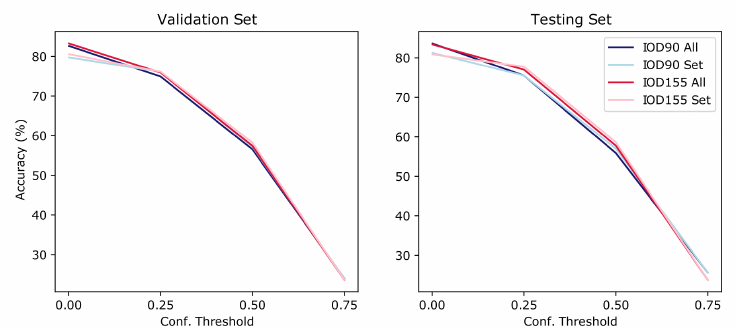
Figure 2. Scene Recognition for IOD90 & IOD155—visualization of results across conf. thresholds (0.001, 0.25, 0.50, 0.75) for validation and testing sets. Also displayed are whether all detected objects or singular instances (sets of objects) are used in predicting room